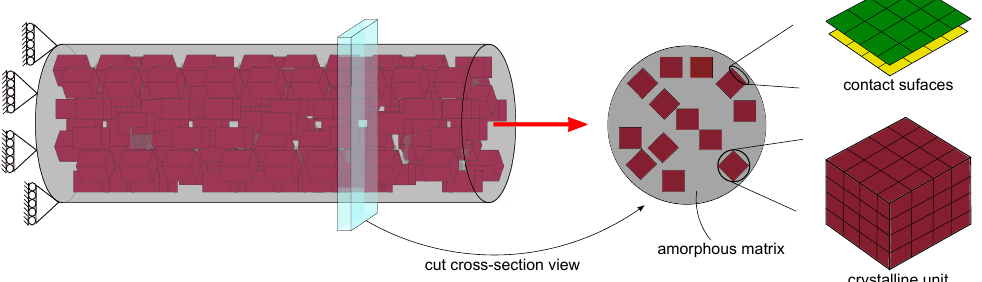
Figure 2. Finite element 3D model of dragline silk fiber (with fixed boundary conditions at one end and pulled condition at another end) on the left, and a cross-sectional view on the right. It is a cylindrical model with solid crystal blocks (red) randomly distributed in the amorphous phase (gray). The crystalline units are connected to the amorphous component along the fiber axis’s direction; however, in the lateral direction (perpendicular to the fiber axis) are surfaces of the crystals (yellow) in contact with surfaces of the amorphous phase